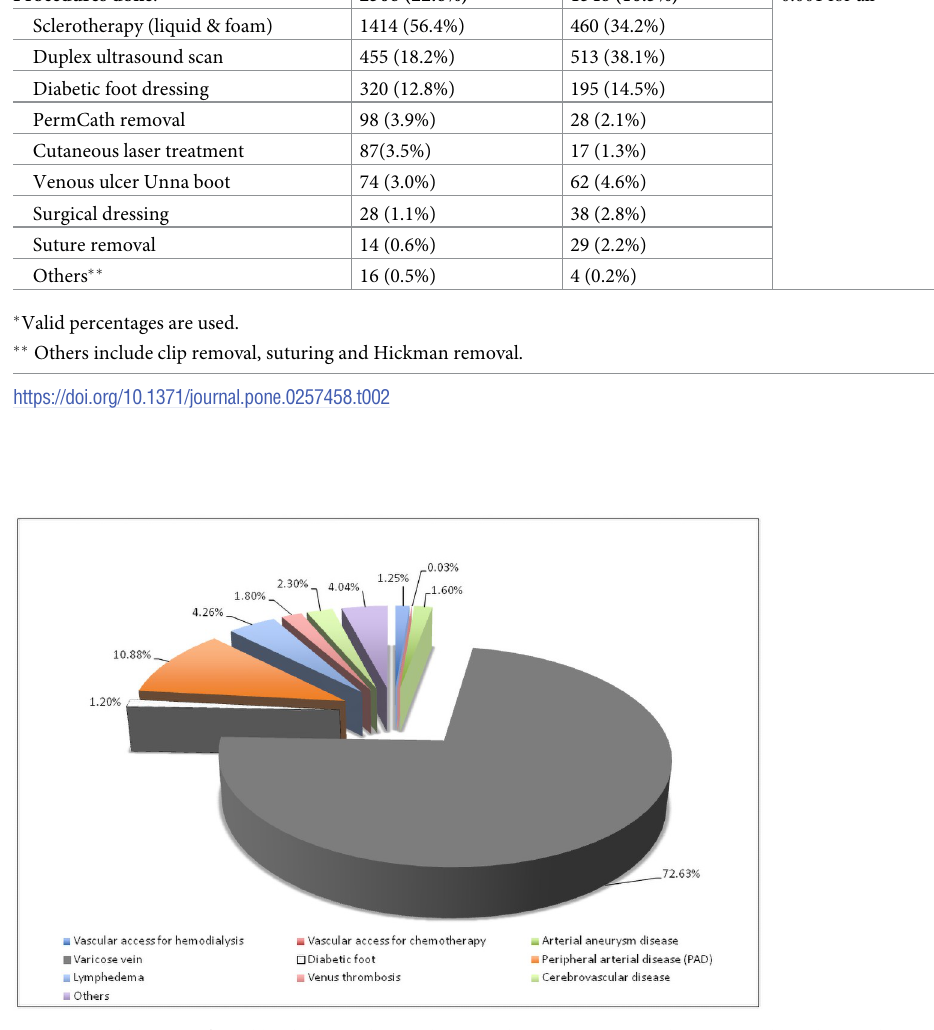
Fig 3. Vascular patients’ workload during the pandemic in the outpatient vascular surgery clinic during the